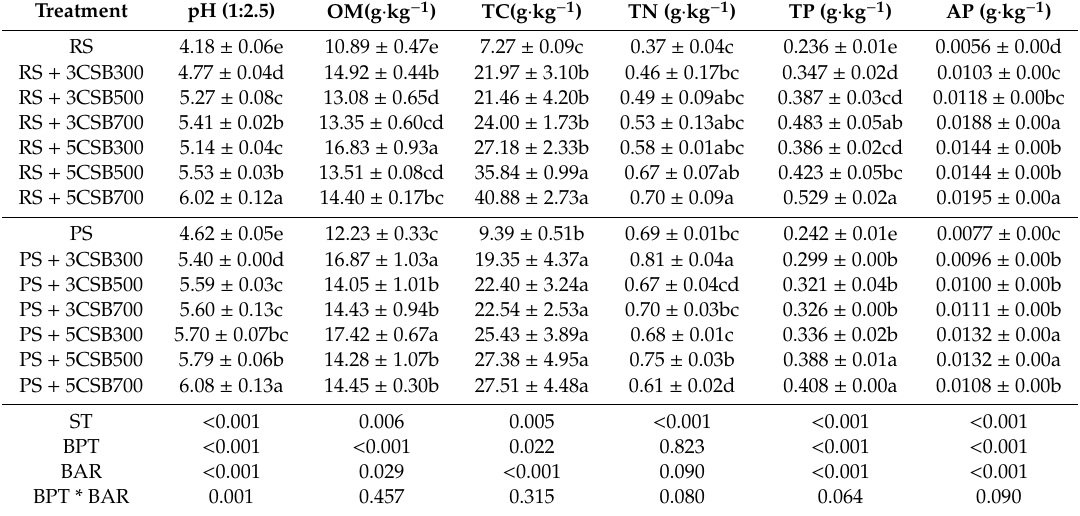
Table 2. Red and purple soil / biochar mixtures properties after incubation of the experiment. Three-way ANOVA for chemical properties measured in both soils. The table shows P value for the three factors: soil type (ST), biochar pyrolysis temperature (BPT) and biochar application rate